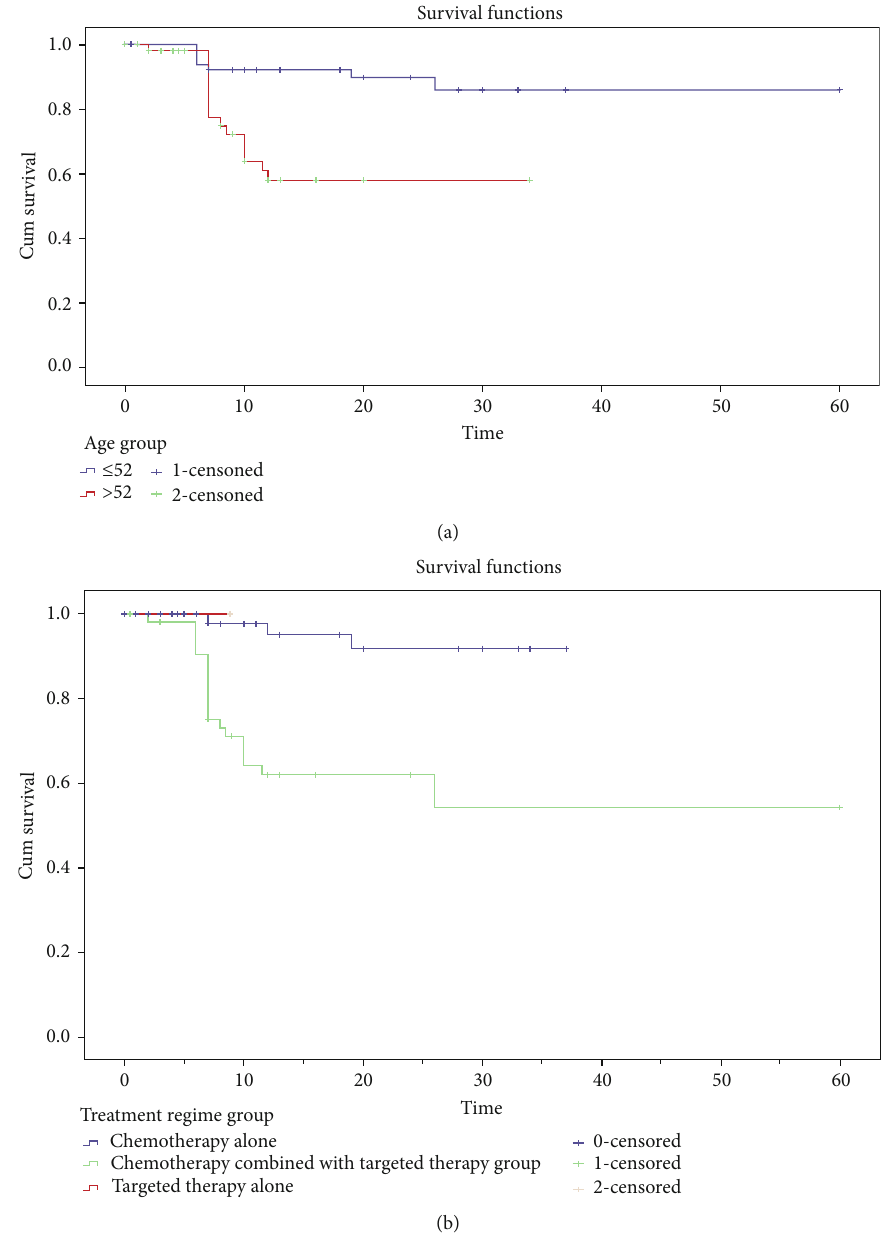
Figure 3: Progression-free survival (PFS) curves for patients with DLM. (a) A curve of PFS time related to age for DLM patients. (b) A curve of PFS time related to the treatment regimens for DLM patients. Abbreviations: DLM: disappearing liver metastasis; PFS: progression-free